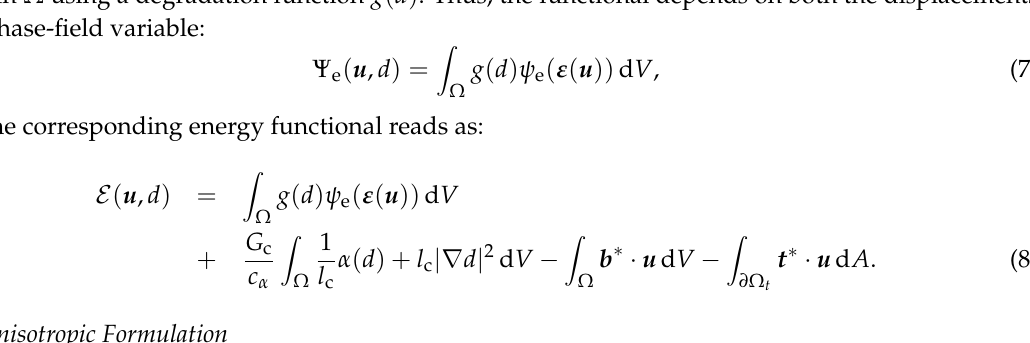
/ l c ) for the PF-B model or x −| |